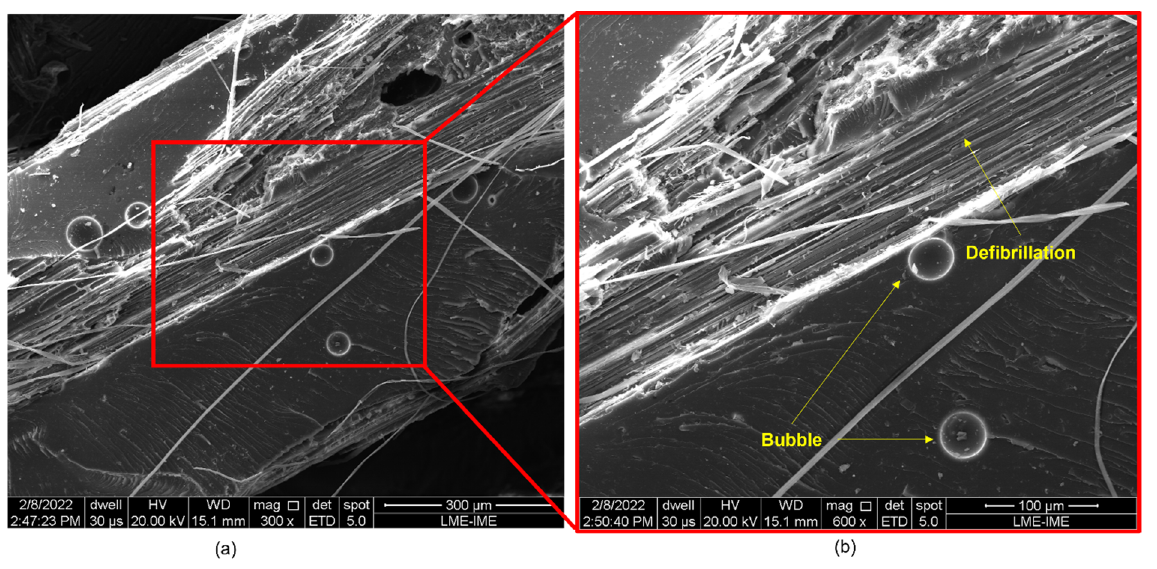
Figure 10. Fracture surface of a composite with 20 vol.% of fibers (PNT/EGO) arranged: unidirec- tionally ( a ) and bidirectionally ( b ), at 200× magnification.